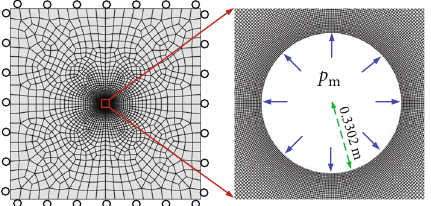
Figure 3: Finite element mesh of the wellbore stability analysis model in this